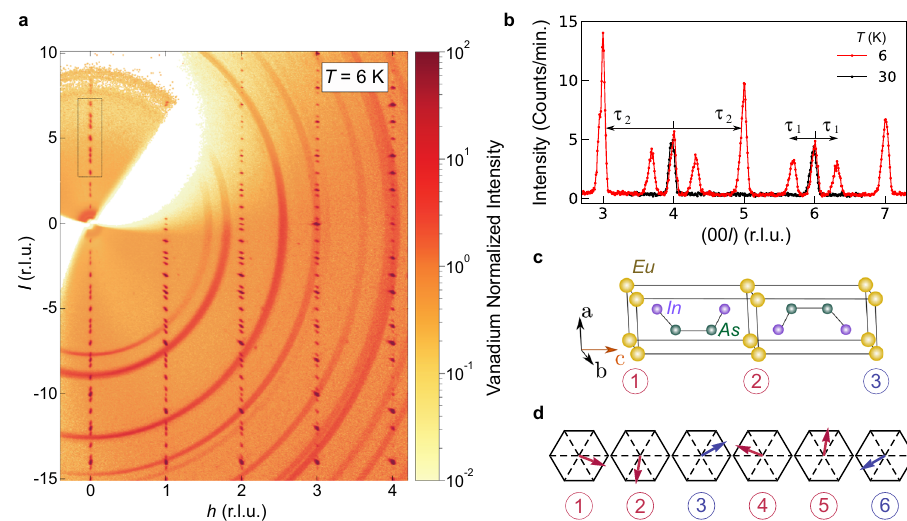
Fig. 1 Neutron diffraction determination of the broken-helix magnetic order. a Data for the ( h 0 l ) reciprocal-lattice plane measured at a temperature of T = 6 K with the CORELLI spectrometer 25 . Bragg peaks from the single-crystal sample appear as dots, whereas Bragg peaks due to the polycrystalline Al sample holder appear as rings centered at 0. b Scans along the (00 l ) reciprocal-lattice direction for 6 K (red) and 30 K (black) made with the TRIAX instrument. The 30 K data show Bragg peaks solely due to the chemical lattice, and the two sets of magnetic Bragg peaks appearing in the 6 K data are labeled by the antiferromagnetic propagation vectors τ 1 = (0, 0, τ 1 z ), with τ 1 z = 0.303(1), and τ 2 = (0, 0, 1). [ τ 2 = (0, 0, 1) is equivalent to τ 2 = (0, 0, 0) for P 6 mmc . We use τ = (0, 0, 1) to facilitate presentation of the diffraction data.] c Chemical unit cell of EuIn 3 / 2 2 As 2 where the numbers correspond to labeling in panel d . d Layer-by-layer diagram of the 6 K broken-helix order using the notation of the hexagonal chemical unit cell. The magnetic unit cell is actually orthorhombic and is tripled along c with the a ortho and b ortho orthorhombic unit-cell axes lying along ½ (cid:1) 110 (cid:2) and − [110], respectively. Each Eu layer is ferromagnetically aligned with the ordered magnetic moments lying in the ab plane. The two symmetry-inequivalent magnetic Eu sites in the magnetic unit cell are colored red (layers 1, 2, 4, and 5) and blue (layers 3 and 6). Moments in the blue layers are constrained by symmetry to lie along ½ (cid:1) 110 (cid:2)